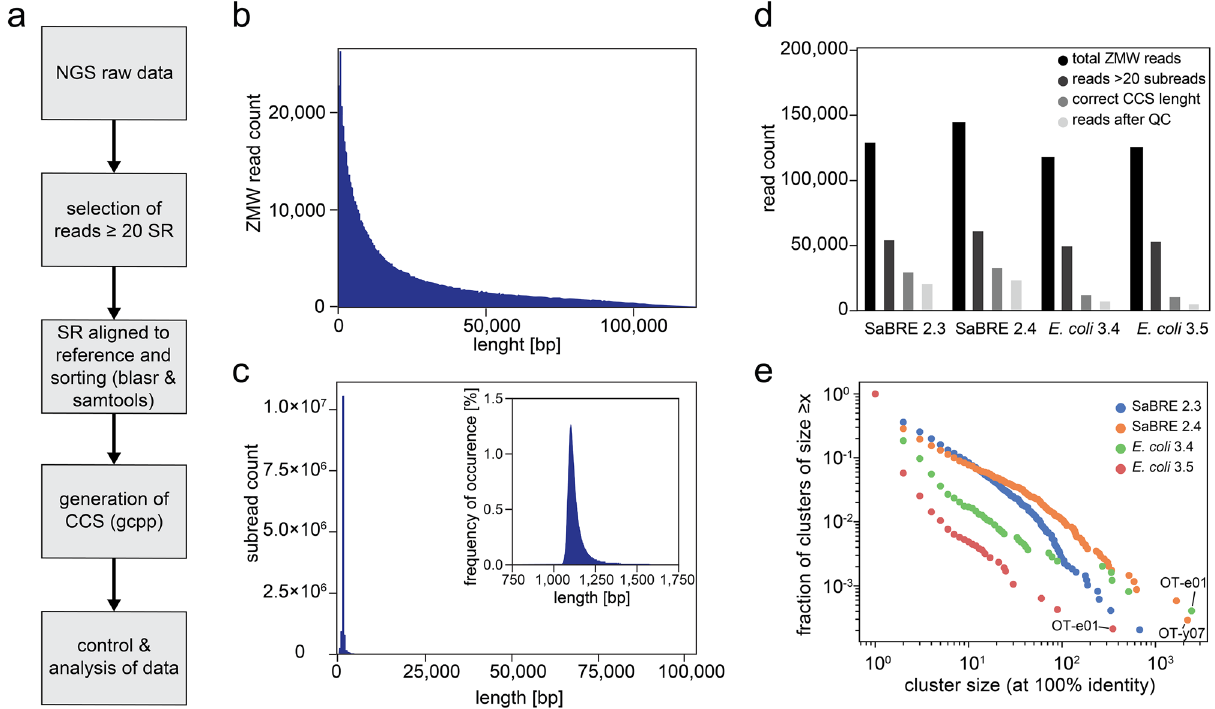
Figure 3. Single-molecule real-time sequencing of OTR selection pools. ( a ) NGS data processing work-flow. ( b ) Histogram representation of all reads and the respective read lengths generated during SMRT sequencing. ( c ) Histogram representation of all subreads and the respective subread lengths generated during SMRT sequencing. Blow-up of the main peak is depicted in the top right corner. ( d ) Diagram of read counts retained after the indicated processing steps (top right corner) for all four pools sequenced. ( e ) Scatter plot of the cluster sizes and the fraction of clusters observed within the indicated (top right corner) sequence pools . The cluster size represents the number of times a particular unique sequence is observed. The fraction of clusters is obtained by counting all clusters of size x divided by the total number of